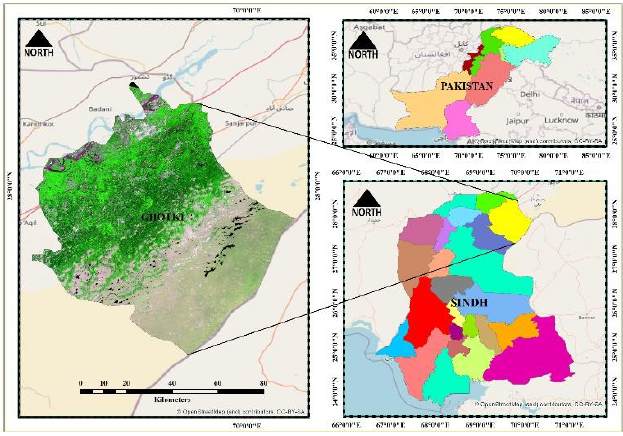
Figure 1: Layout base map of Ghotki district, Sindh, Pakistan